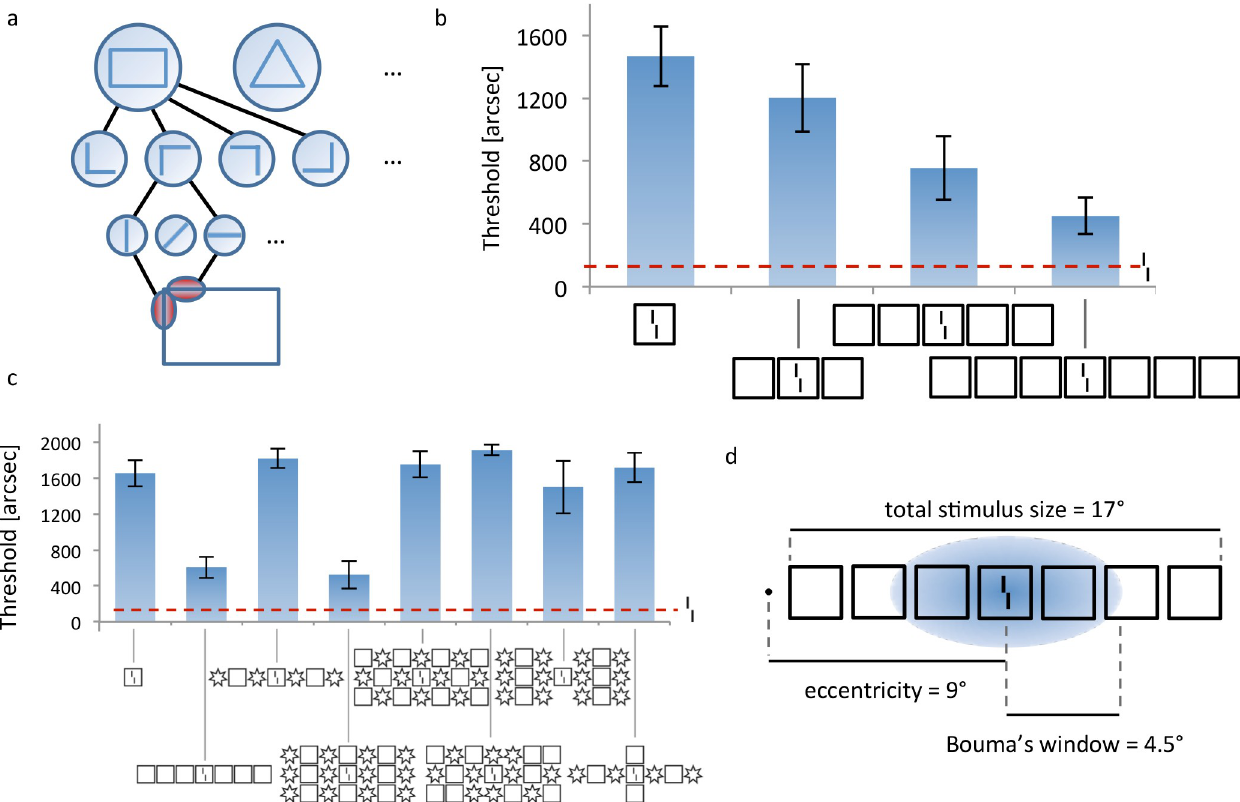
Fig 2. a. Standard view of visual processing. First, edges are detected by low-level neurons with small receptive fields. Higher level neurons pool signals from lower level neurons in a hierarchical, feedforward manner, creating higher level representations of objects by combining low-level features [25,26]. For example, two low-level edge detectors may be combined to create a “corner” representation. Four such corner detectors can be assembled to create a rectangle representation. Receptive field size naturally increases along this pathway since, for example, a rectangle covers larger parts of the visual field than the lines making up the rectangle. b. Uncrowding. Observers performed a vernier discrimination task. The y-axis shows the threshold for which observers correctly discriminate the vernier offset in 75% of trials (so performance is good when the threshold is low). First, only a vernier is presented, an easy task (performance for this condition is shown as the dashed horizontal line). Then, a flanking square is added making the task much more difficult (leftmost stimulus). This is a classic crowding effect. Importantly, adding more flanking squares improved performance gradually, i.e., performance improved the more squares are presented [19]. We call this effect uncrowding. c. The global configuration of the entire stimulus determines crowding. Performance is strongly affected by elements far away from the target as shown in these examples [15]. d. Performance is not determined by local interactions only . In this display, fine-grained vernier acuity of about 200” depends on elements as far away as 8.5 degrees—a difference of two orders of magnitude, extending far beyond Bouma’s